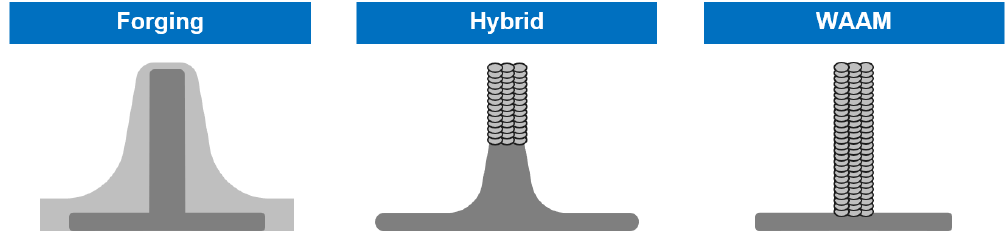
Figure 1. Illustration of the possible hybrid manufacturing route combining metal hot forming and WAAM.